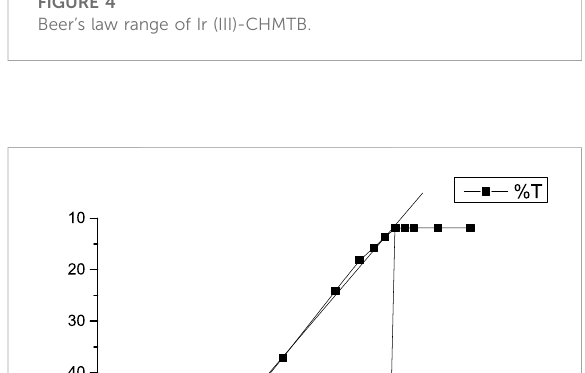
FIGURE 4 Beer ’ s law range of Ir (III)-CHMTB.